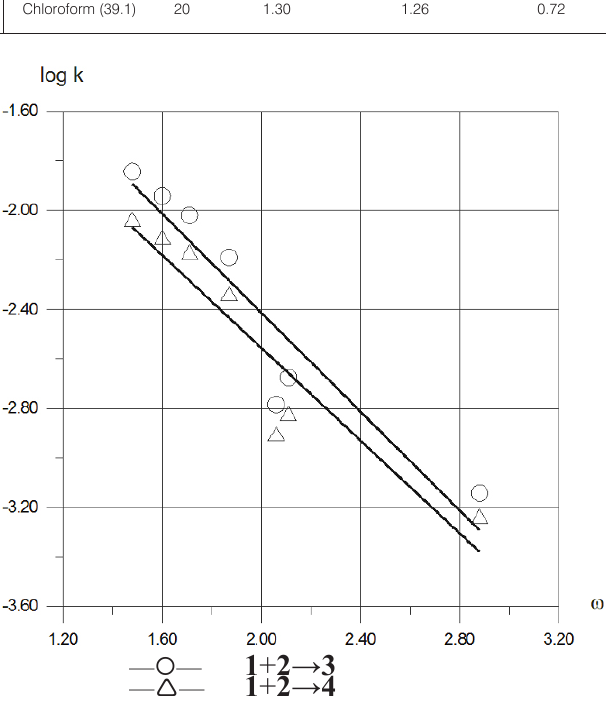
Figure 2. Plot of log k vs global electrophilicity index ω for [2+3] cycloaddition between 1-chloro-1nitroethene 1 and (Z)-C-aryl-N-phenylnitrones 2a-g Good correlations log k versus ω and log k versus N confirmed, that these reaction can be considered in terms in Domingo terminology [ 21 ] as polar process.